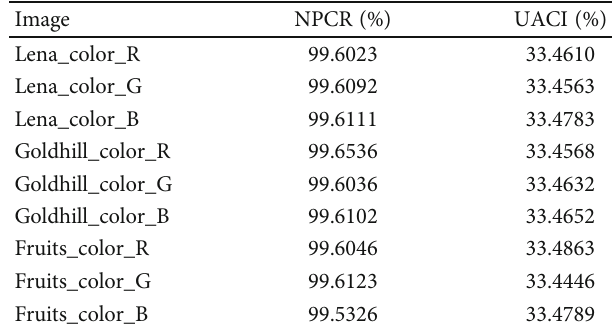
Table 2: Comparison of correlation coe ffi cients. Table 3: Average NPCR and UACI values between two